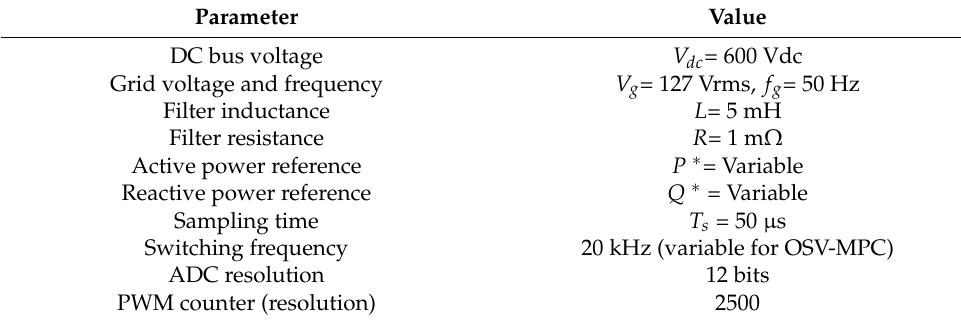
Table 3. Parameters used in the experimental